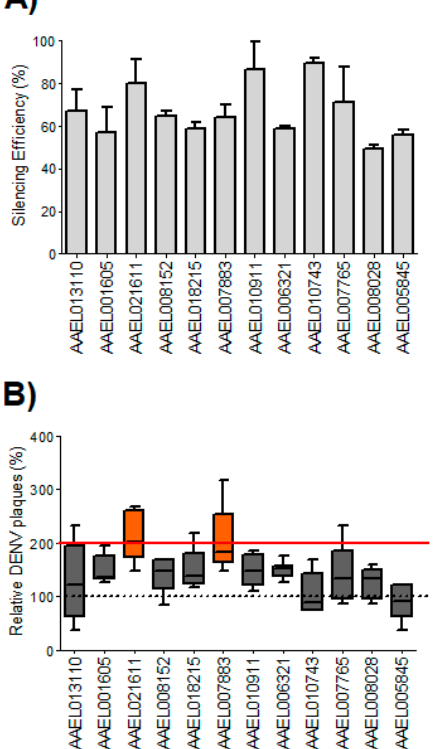
Figure 1. siRNA-mediated silencing assay during Dengue virus 2 (DENV2) infection in Aag2 cells. ( A ) Silencing efficiencies were determined by quantitative real-time PCR compared to the non-silenced control ( β -gal siRNA transfected) and presented as means and standard errors (n = 3). Mean silencing efficiencies ranged from 49.37% to 89.34% compared to the control group. ( B ) Putative anti-DENV2 function of twelve homologs of human West Nile virus (WNV)/DENV2 resistance genes were tested using siRNA silencing assays in Aag2 cells. For each assay result, DENV2 titers are presented as means and standard errors (n = 6). The highlighted bars (AAEL021611 and AAEL007883;) indicate that silencing of the genes increased DENV2 titers (Mann-Whitney U test, p = 0.002 and p = 0.008, respectively) nearly two-fold higher than the β -gal silenced controls (normalized to 100%, dotted line). The red line indicates a two-fold increase over